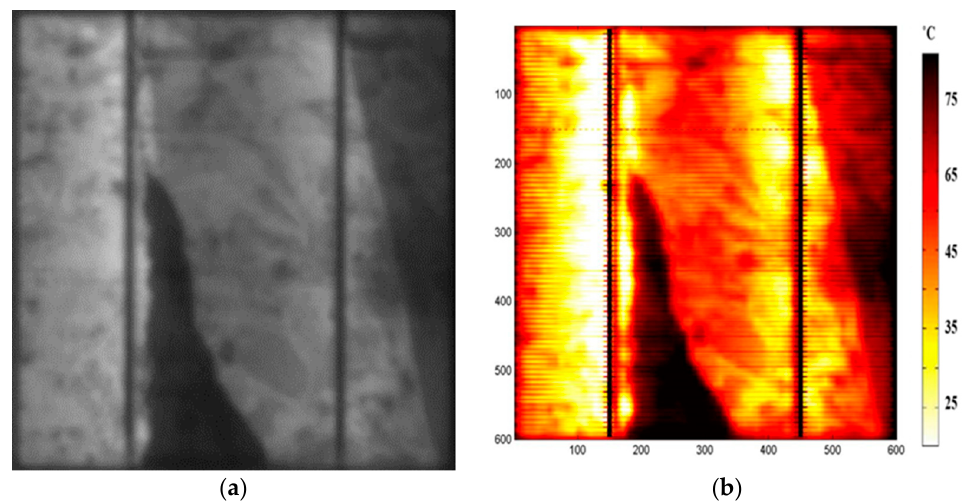
Figure 1. Failure modes in solar cells: ( a ) Microcracked solar cell, this image is taken using an Electroluminescent (EL) imaging camera; ( b ) hotspot solar cell (this image was taken using a FLIR thermal imaging camera) [15].